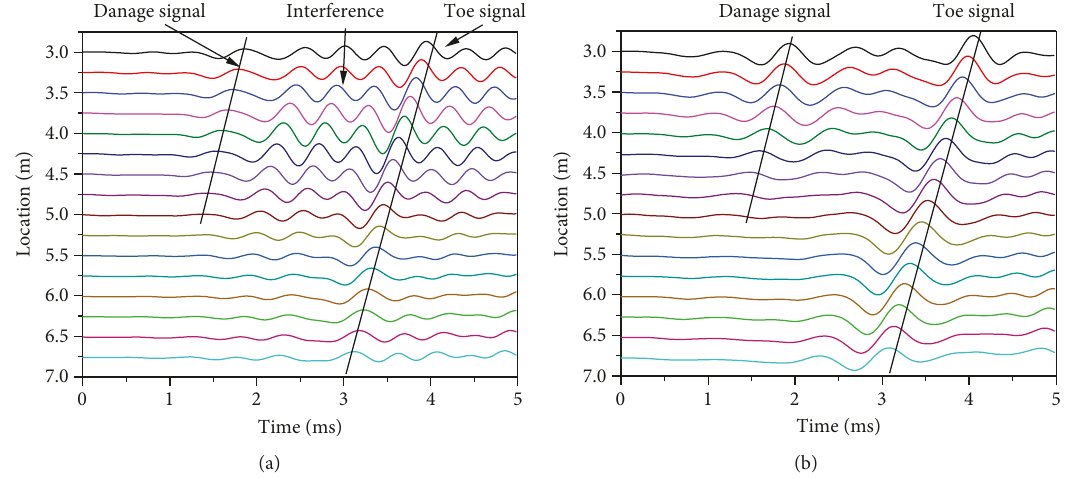
Figure 25: Upward velocity data. (a) Velocity data at A